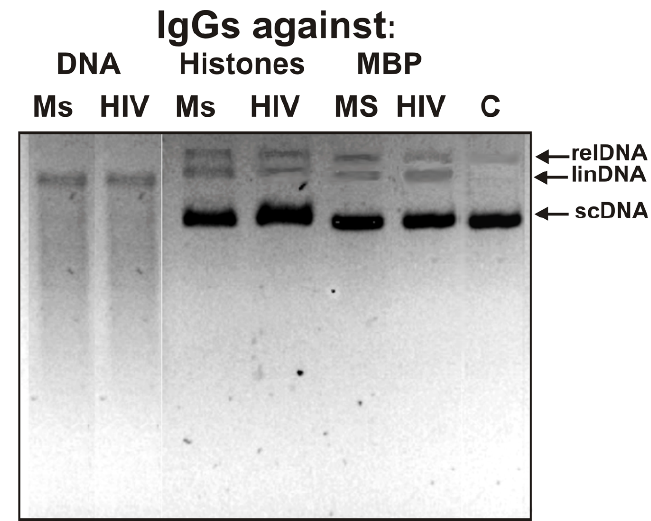
Figure 1. Analysis of the relative activity of IgGs against DNA, five different histones, and MBP in the hydrolysis of supercoiled DNA for 3 h from MS and HIV-infected patients. Designations of IgGs and diseases are shown in the figure: supercoiled DNA (scDNA), relaxed DNA (relDNA containing one break), linear DNA (linDNA containing several breaks).